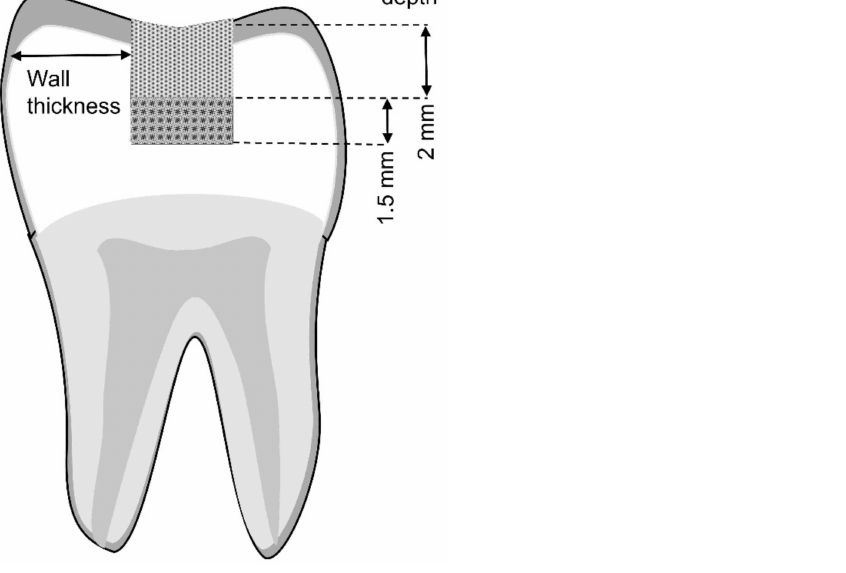
Figure 1. The author’s schematic faciolingual cross-section of the cavity depth (occlusal and proximal) prepared in molars subjected to the maximum fracture load